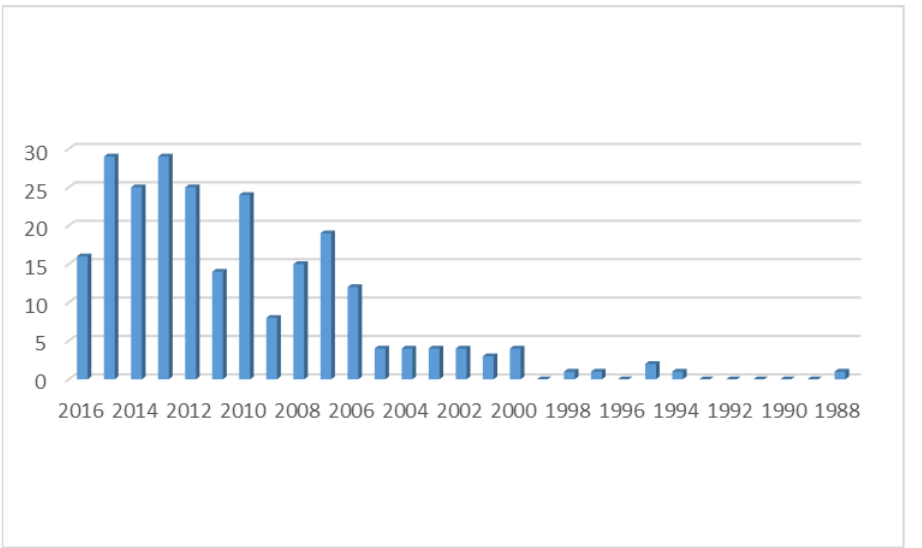
Figure 1. Distribution of work per